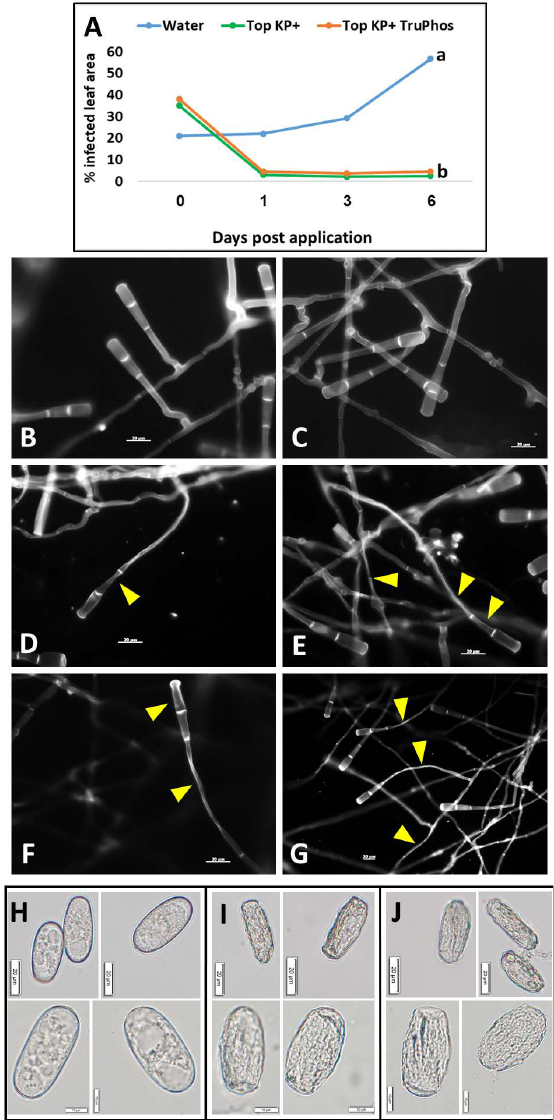
revealed normal conidia in untreated control leaves (Figure 10H) but plasmolyzed conidia in treated leaves (Figure 10I,J).